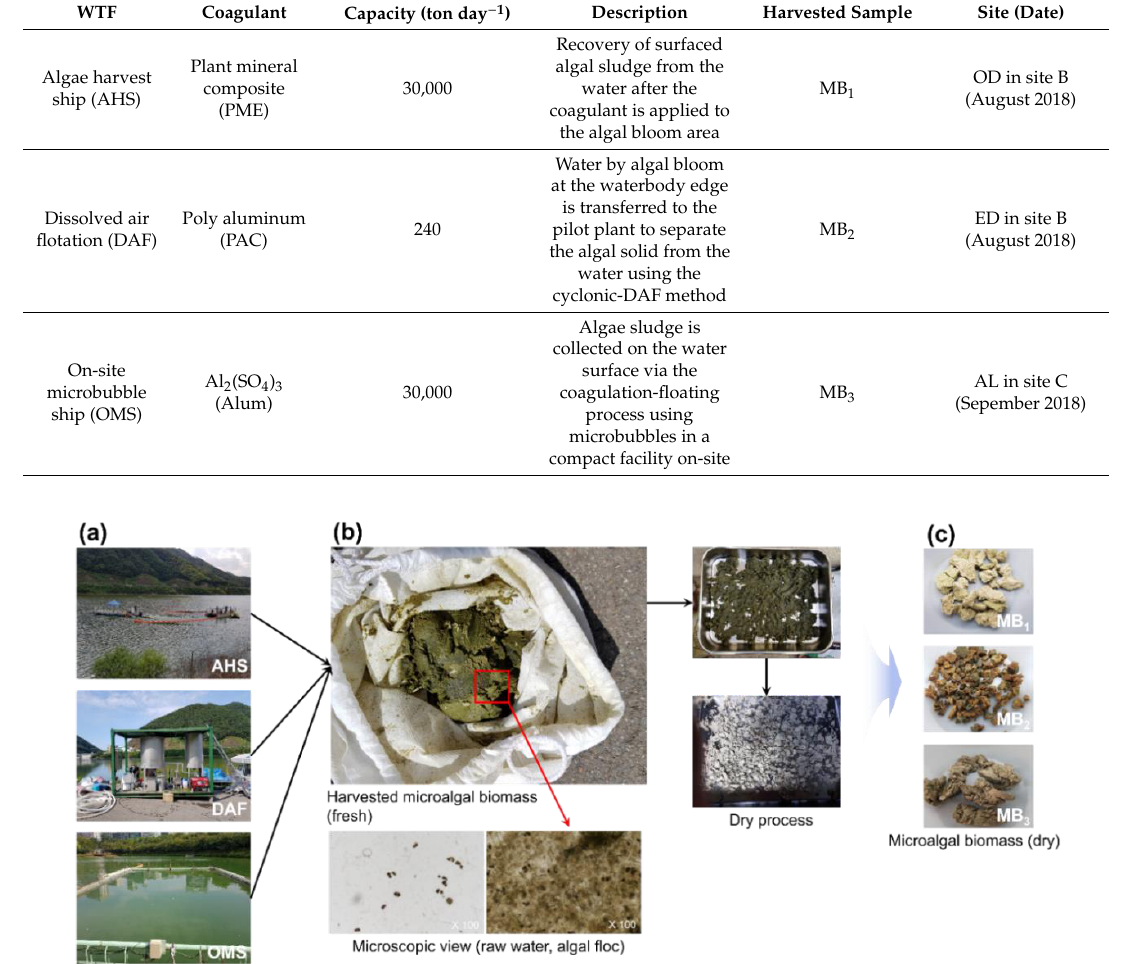
Table 1. Summary of harvested MB samples in the di ff erent surface water by various WTFs.